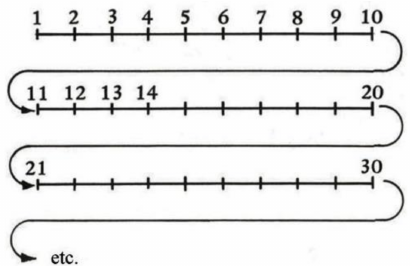
Figure 7. The one hundred square as an extension of the number line in Wiskobas [39] (p. 60).